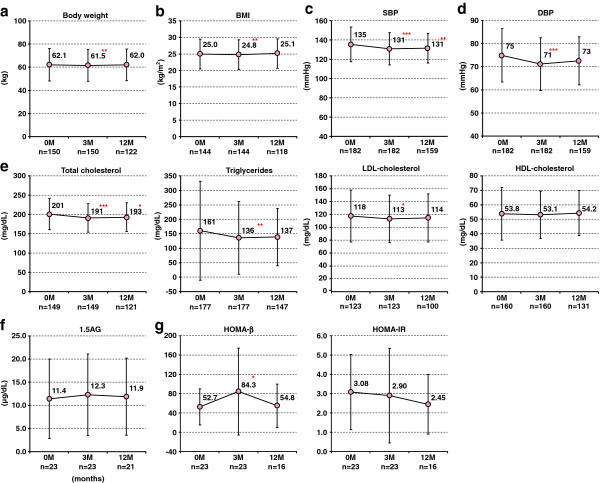
Serial changes of (a) body weight, (b) BMI, (c) blood pressure, (d) lipid profiles including total cholesterol, triglycerides, LDL-cholesterol and HDL-cholesterol, (e) 1.5 AG, and (f) HOMA-β and –IR. M, months; SBP, systolic blood pressure; DBP, diastolic blood pressure; LDL, low-density lipoprotein; HDL, high-density lipoprotein; 1.5-AG, 1.5-Anhydro-D-glucitol; HOMA-β, homeostasis model assessment analyses of beta cell function; HOMA-IR, insulin resistance. *p < 0.05, **p < 0.01, ***p < 0.001, vs. baseline by paired t-test.